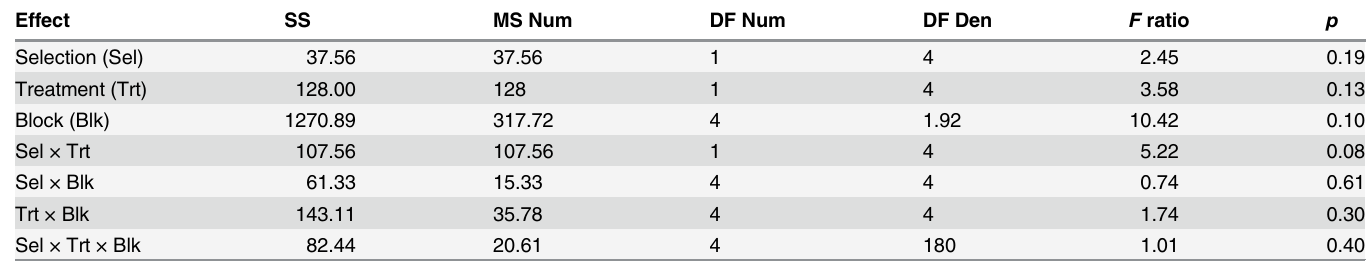
Table 5. Effect of cold shock on larval survivorship (Experiment 2).